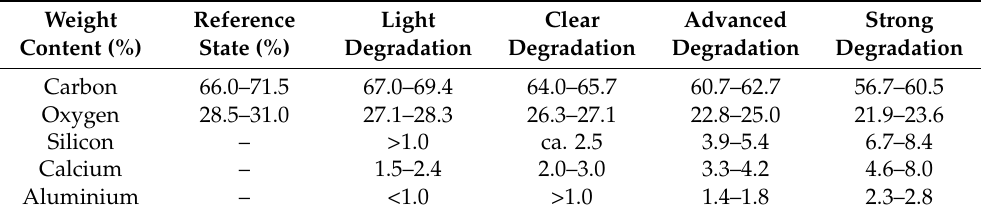
Table 3. Changes in the elemental composition of the top layer of the textolite material in per cent by weight for the subsequent stages of progressive material degradation. Data were based on EDS X-ray microanalysis. Carbon and oxygen were part of the epoxy resin (organic binder). Silicon, calcium and aluminium, as well as some oxygen, were components of the glass fibres of the fabric, i.e., the support of the laminate. In the case of very strong degradation of the material, there was a large scatter of the results and it was difficult to provide reliable